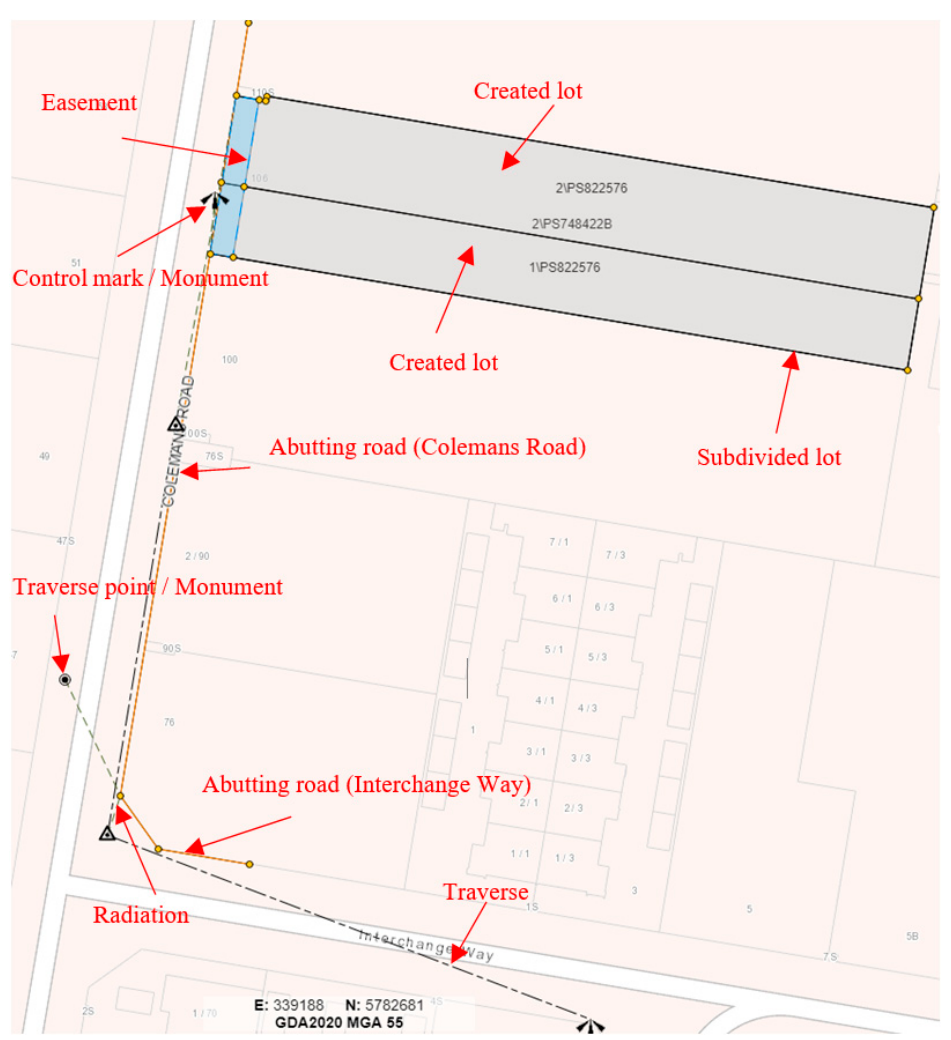
Figure 8. Sample dataset used for the PoC evaluation.